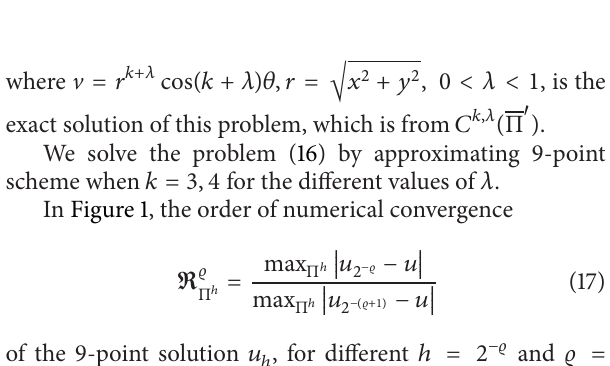
Figure 1: Dependence of the approximate solutions for the bound- ary functions from 𝐶 𝑘,𝜆